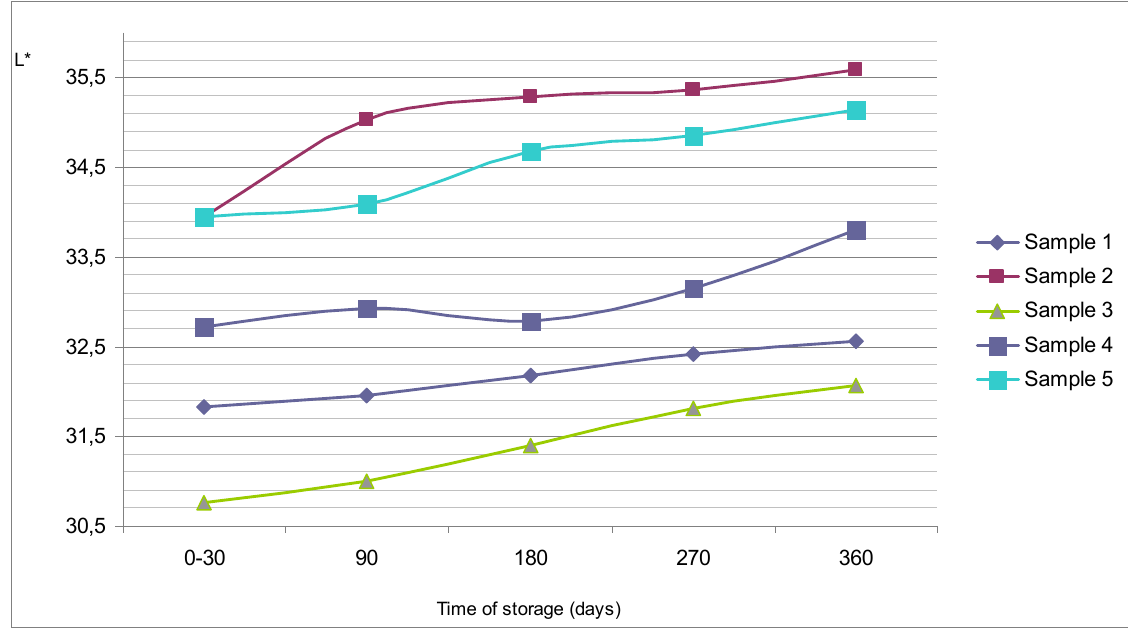
Figure 4. Changes of psychometric light (L*) on the top surface of samples of dietary chocolates during storage of 360 days.